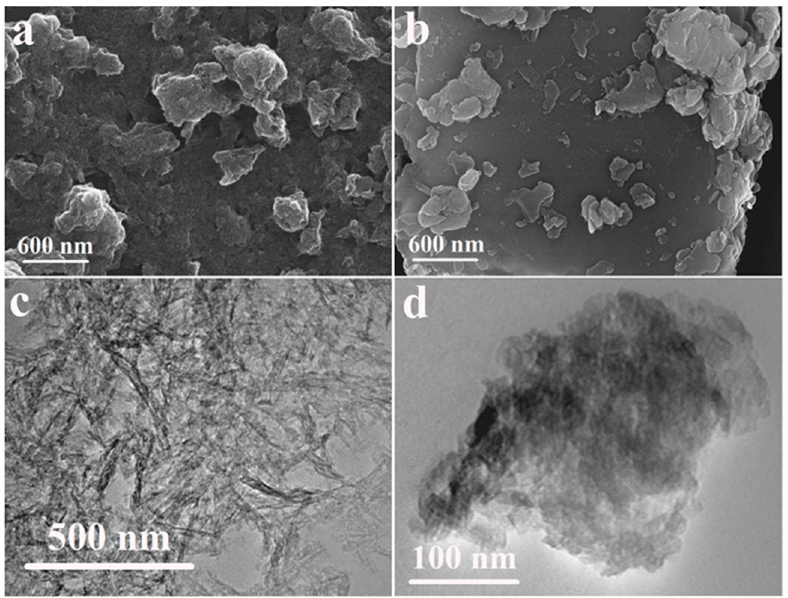
Figure 1. SEM and TEM images of PB ( a , c ) and SB ( b , d ) samples. Powder X-ray diffraction (XRD) pattern measurements were performed to